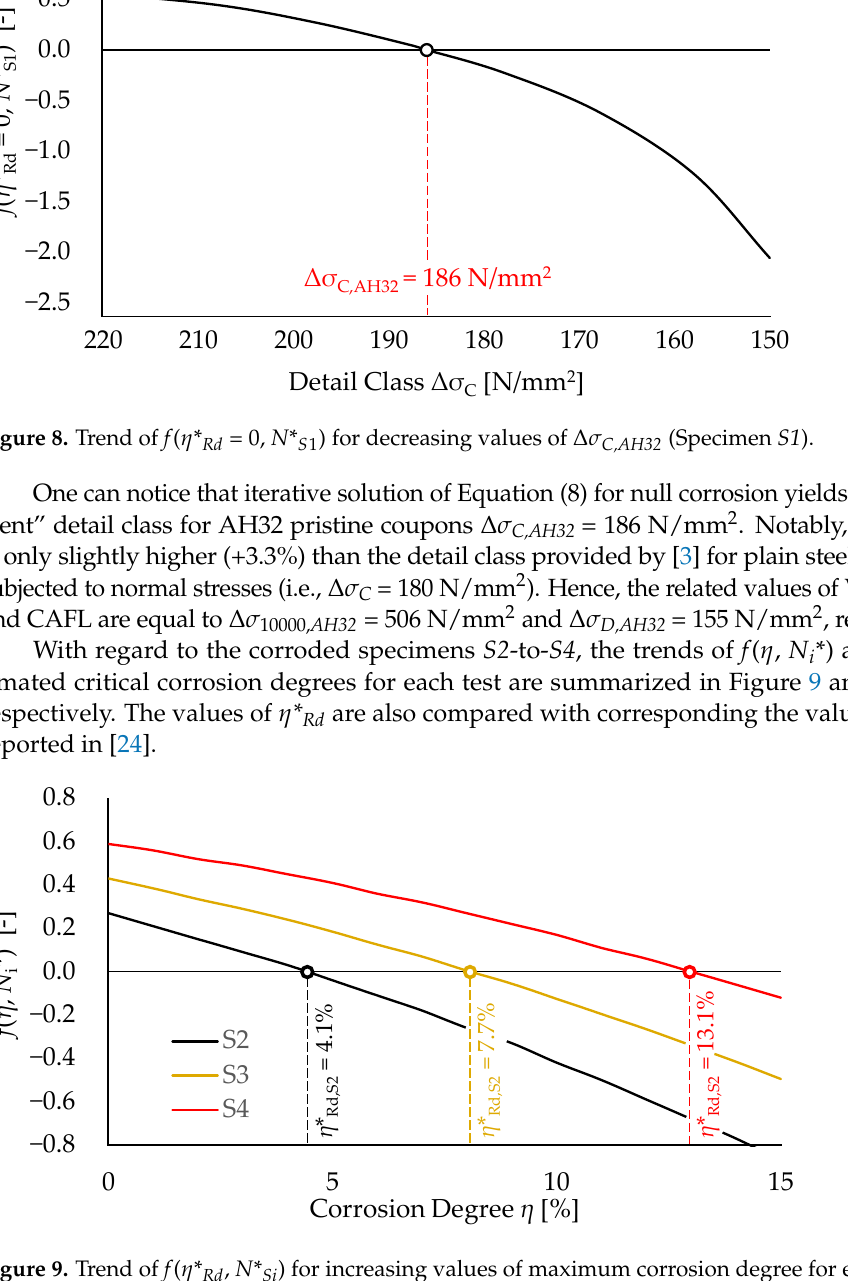
Figure 9. Trend of f ( η * Rd , N * Si ) for increasing values of maximum corrosion degree for each consid- ered corroded specimen ( S2 -to- S4 ). Table 3. Estimated values of critical corrosion degree for specimens S2 -to- S4 .